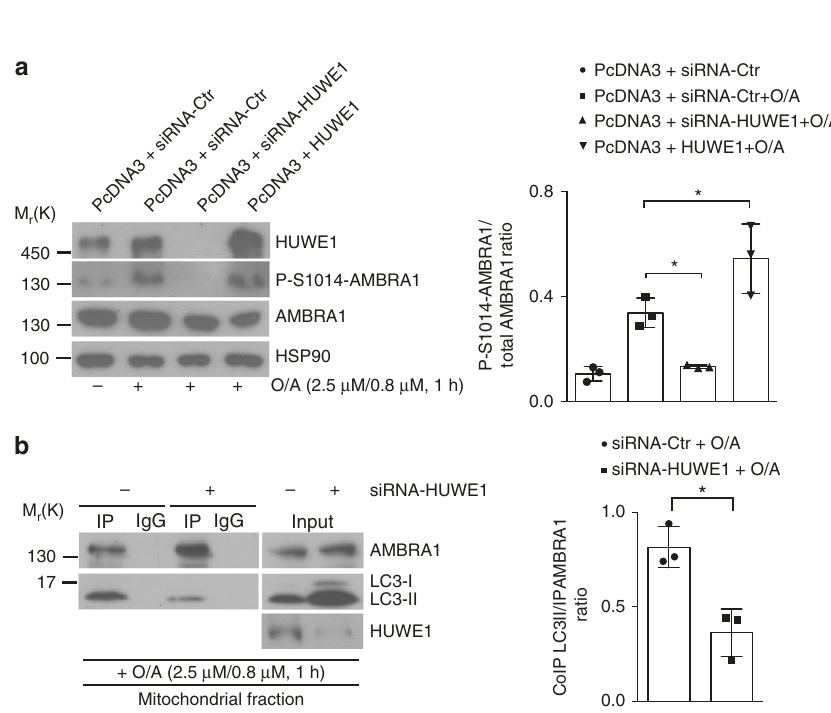
Fig. 6 HUWE1 is crucial for AMBRA1 – S1014 phosphorylation. a HeLa cells were transfected with an empty vector (PcDNA3) in combination with a siRNA- Ctr or a siRNA-HUWE1 or a plasmid encoding for HUWE1. Cells were treated with O/A (2.5 μ M, 0.8 μ M, 1 h) and total lysates were blotted for the indicated antibodies; n = 3. b HeLa cells were transfected with siRNA-Ctr or siRNa-HUWE1 and treated with O/A (2.5 μ M, 0.8 μ M, 1 h). Mitochondrial fractions were immunoprecipitated using anti-AMBRA1 antibody; n = 3. Data represent the mean of three different samples (±S.D.) and are representative of experimental triplicate. * P < 0.05. Statistical analysis was performed using one-way anOVA ( a ) or Student ’ s t -test ( b ). M r (K) = relative molecular mass